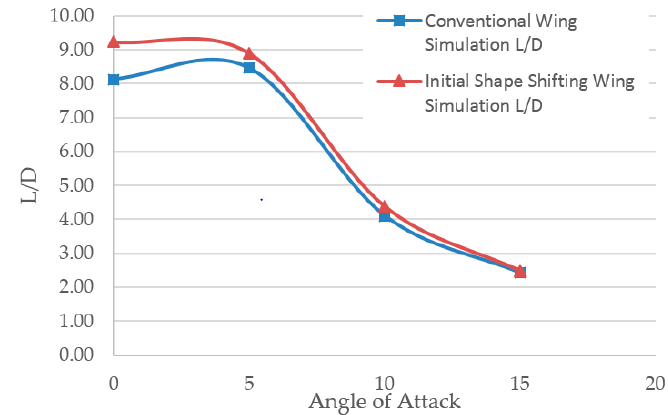
Figure 18. A graph showing Lift/drag otherwise known as the glide ratio for the conventional wing and initial morphing wing.